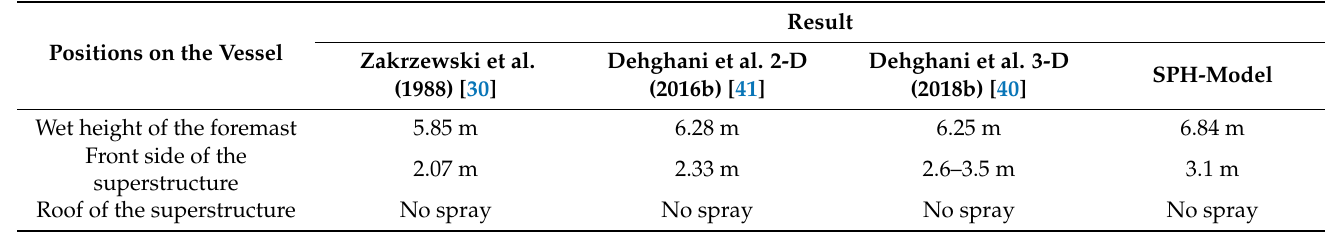
Table 2. A comparison between the results of 2-D and 3-D models, field observations, and previous data.